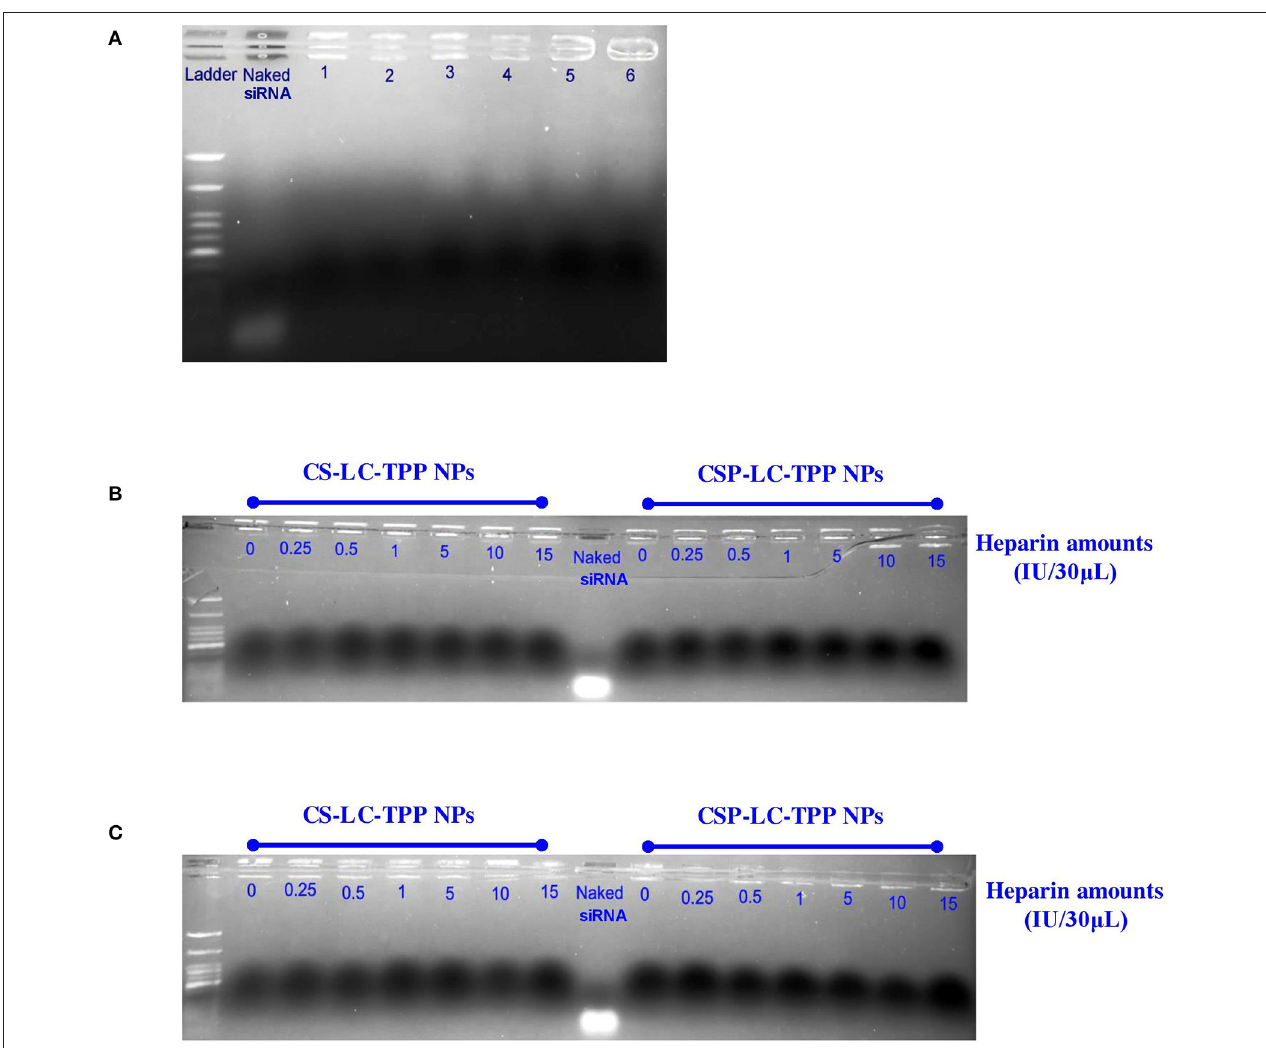
FIGURE 4 | Gel electrophoresis bands for siRNA within loaded NPs: (A) CS-LC-TPP and CSP-LC-TPP NPs in aqueous solution at preparation pH (lanes 1 and 2, respectively), at pH 6.8 in 50% FBS solution (lanes 3 and 4, respectively) and at pH 7.4 in 50% FBS solution (lanes 5 and 6, respectively), (B,C) siRNA-loaded CS-LC-TPP and CSP-LC-TPP NPs in different heparin concentrations at pH 6.8 and 7.4 PBS, respectively. Naked siRNA was used as positive